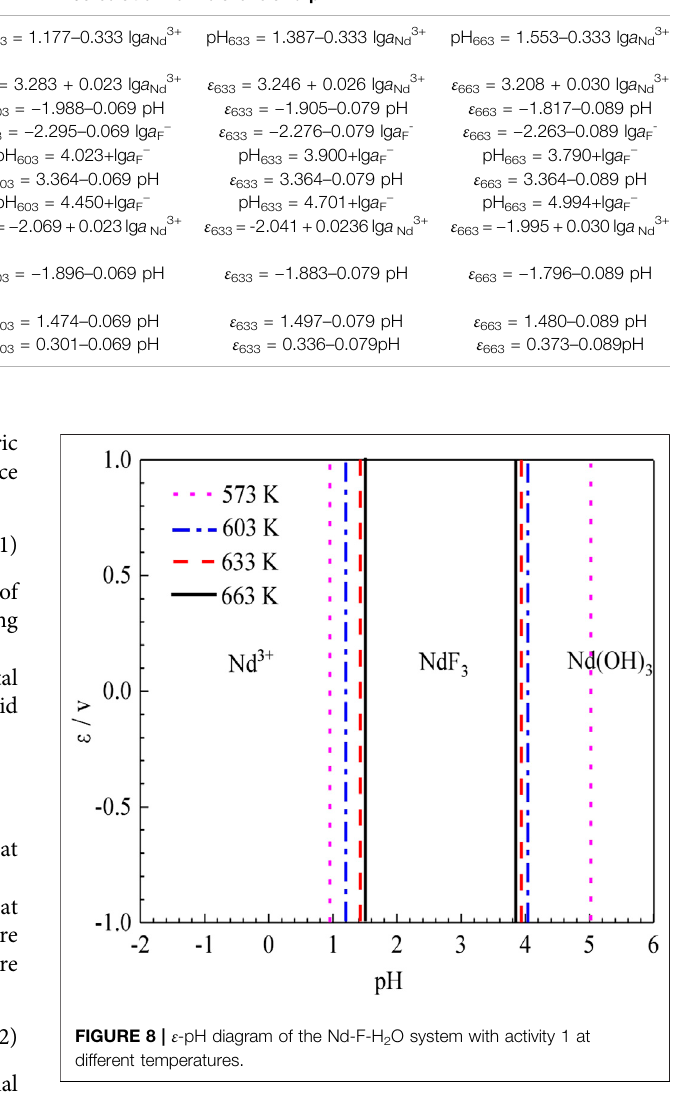
TABLE 1 | Reaction in Nd-F-H 2 O system at 573 – 663 K and calculation formula of ε and pH. Reaction formula Calculation formula of ε and pH